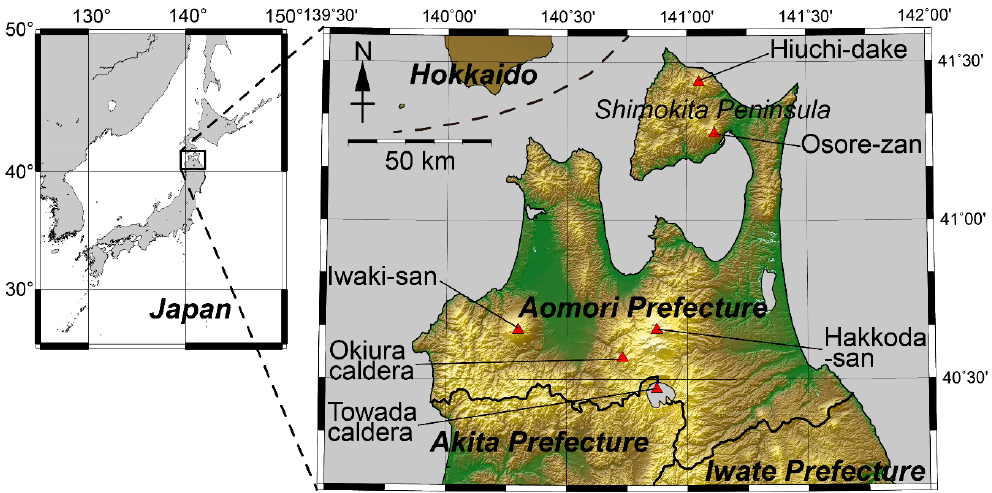
Figure 1. Topographic summary of Aomori Prefecture, Japan. Red triangles indicate the locations of major Quaternary volcanoes and calderas. Map is based on a 10 m-mesh digital elevation model developed by the Geospatial Information Authority of Japan.